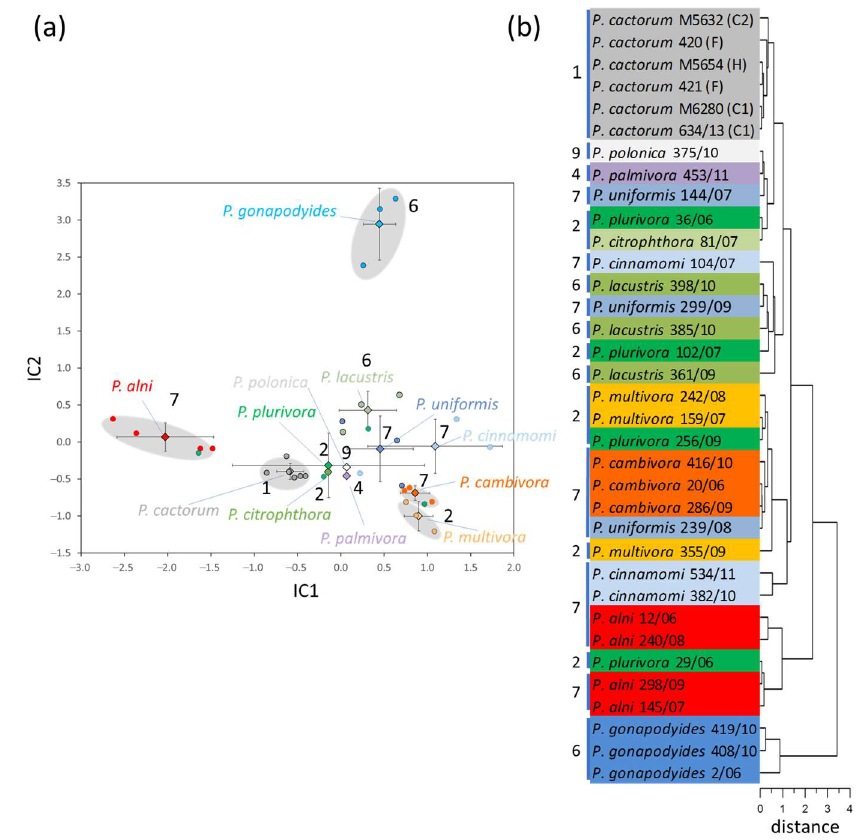
Figure 1. Shotgun proteomics-based clustering of Phytophthora isolates. ( a ) Independent component analysis of 1787 MS1 peak areas (intensity threshold—0.1% of the total ion chromatogram). Circles, diamonds, error bars and the gray shading represent mean profiles of two biologically distinct samples, means, standard deviation, and significant clustering of the species ( p < 0.05; Kruskal–Wallis), respectively. Numbers indicate recognized Phytophthora clades, color corresponds to the individual species; ( b ) Clustering analysis based on IC1 and IC2 coordinates.